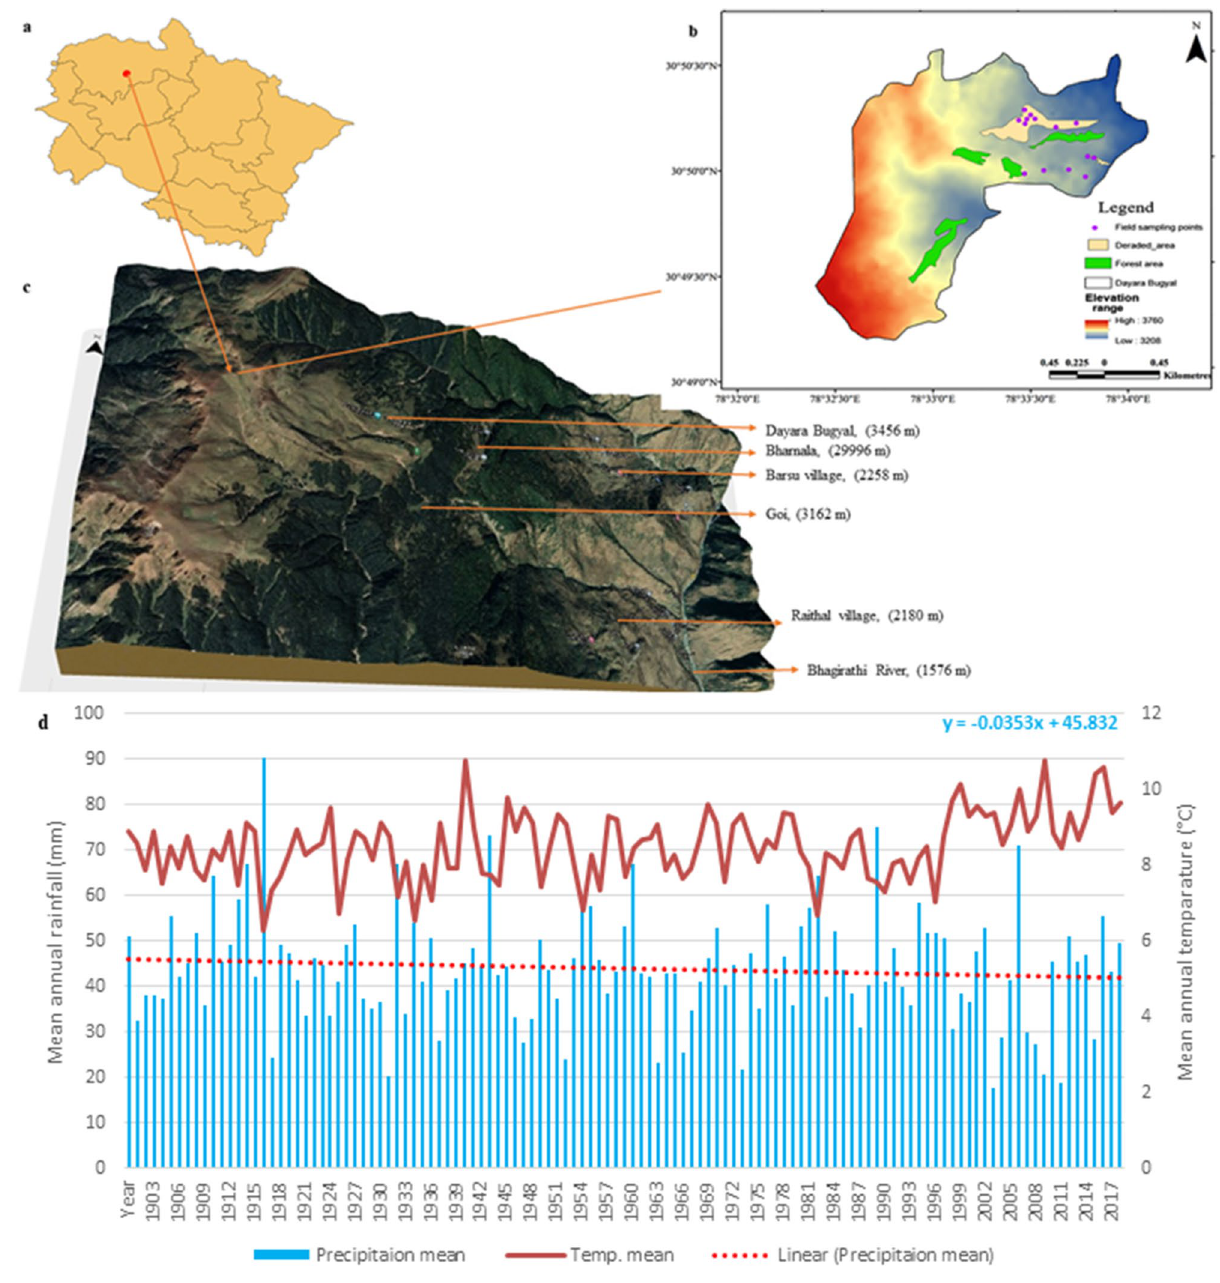
Figure 1. ( a , b , c ) Geographical extent, and ( d ) climatic profile of the study area. {Source: CRU TS 4.04 (land),